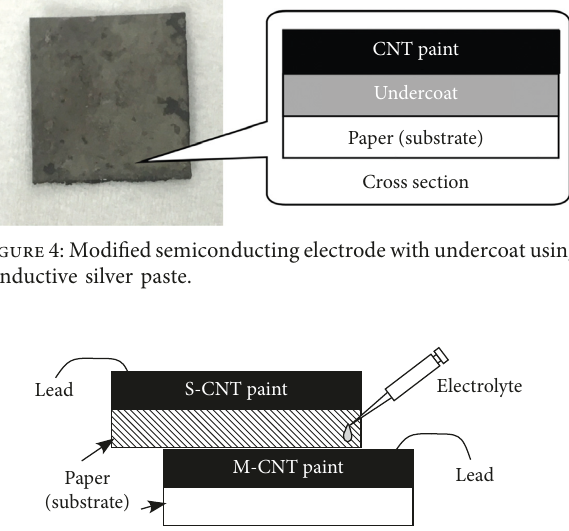
Figure 5: Schematic of paint-type DSC for test. S-CNT indicates semiconducting CNT and M-CNT indicates metallic